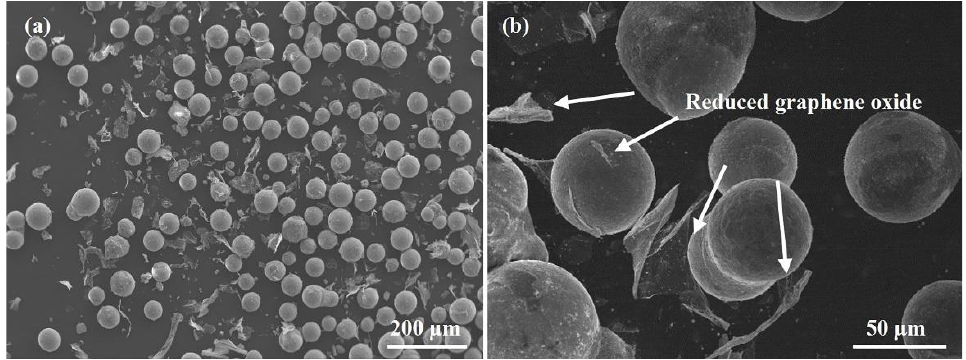
Figure 5. ( a ) SEM image of RGO/ZK61 composite powder and ( b ) details of RGO dispersed in mag- nesium matrix composite